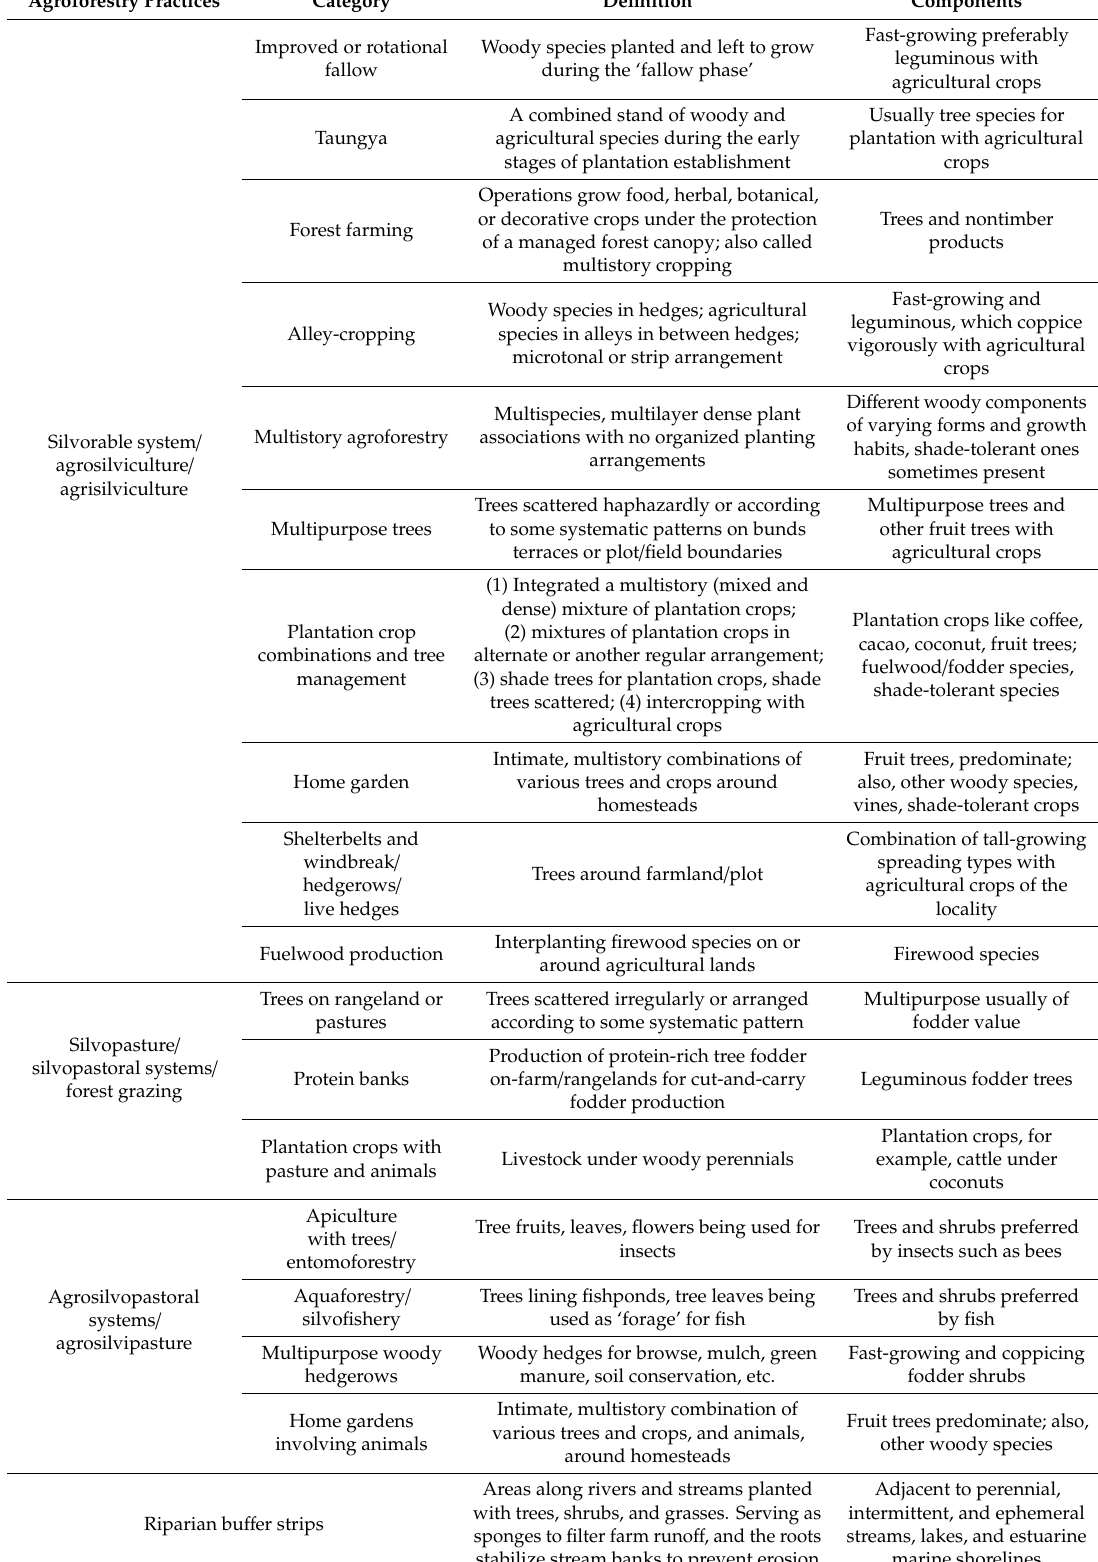
Table 1. Major agroforestry practices